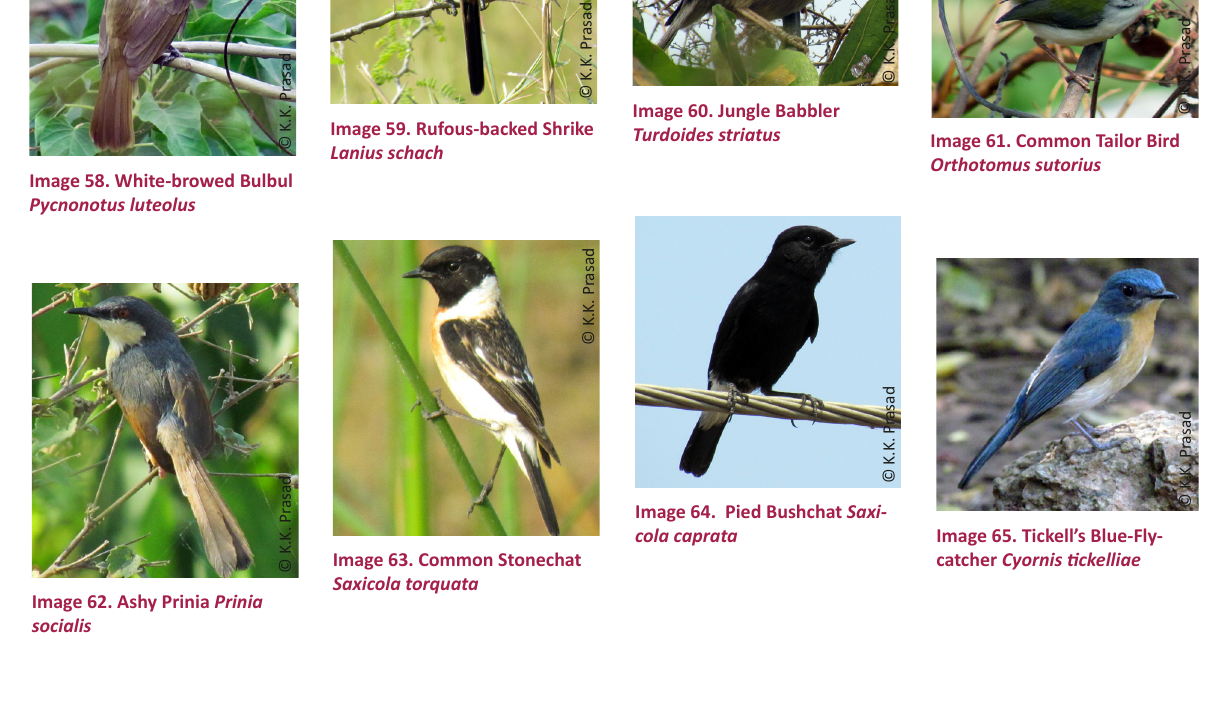
Image 64. Pied Bushchat Saxi- cola caprata Image 65. Tickell’s Blue-Fly-